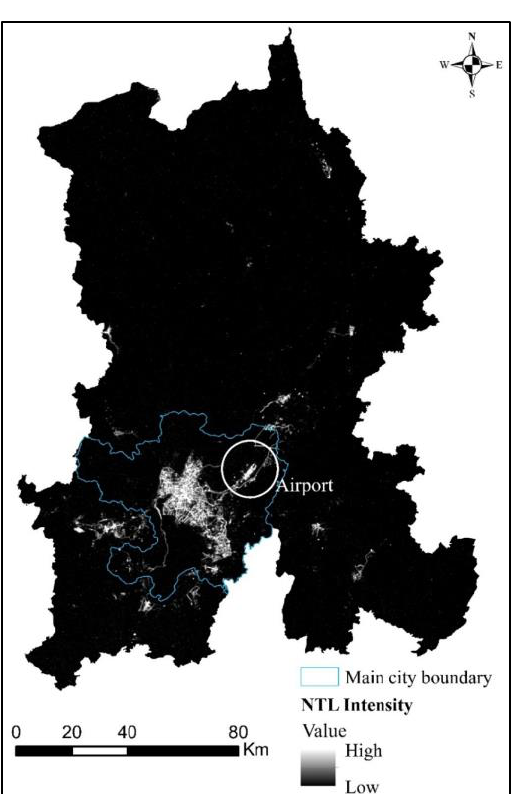
Figure 1. Study area.